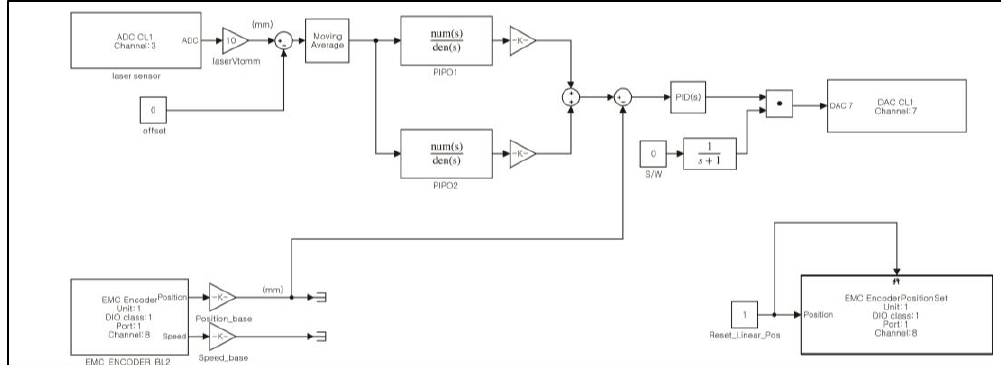
Figure 18. Simulink block diagram.